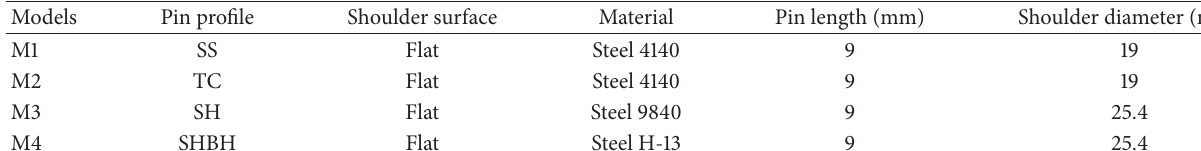
Table 4: Models for the pins according to the tool profile, the material, and dimensions.